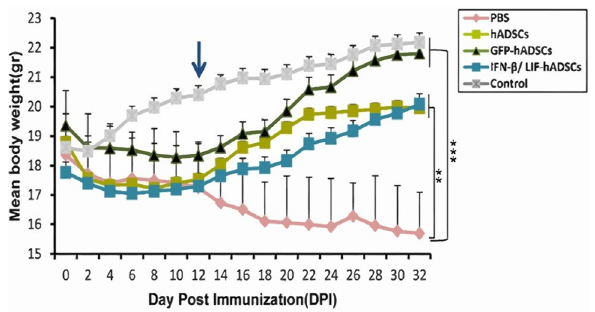
Figure 4. hADSCs overexpressing IFN-β and LIF reduced the weight loss in immunized mice. The body weight of all five groups was monitored daily for up to 32 days after immunization. In general, the mean body weight of the three treatment groups differed significantly compared with PBS mice (F9,14 = 12.951, P = 0.00003). Body weight changes in the three treatment groups compared to the healthy group were not significant. Results were shown as mean ± SEM. * P < 0.05, ** P < 0.01, *** P <